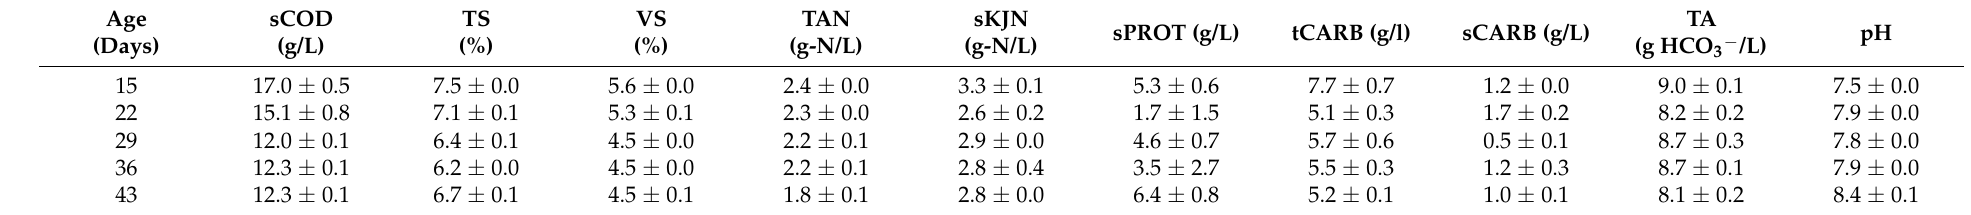
Table 2. Influence of digestate age (in days) on biochemical digestate parameters: soluble chemical oxygen demand (sCOD), total solids (TS), volatile solids (VS), total ammonia